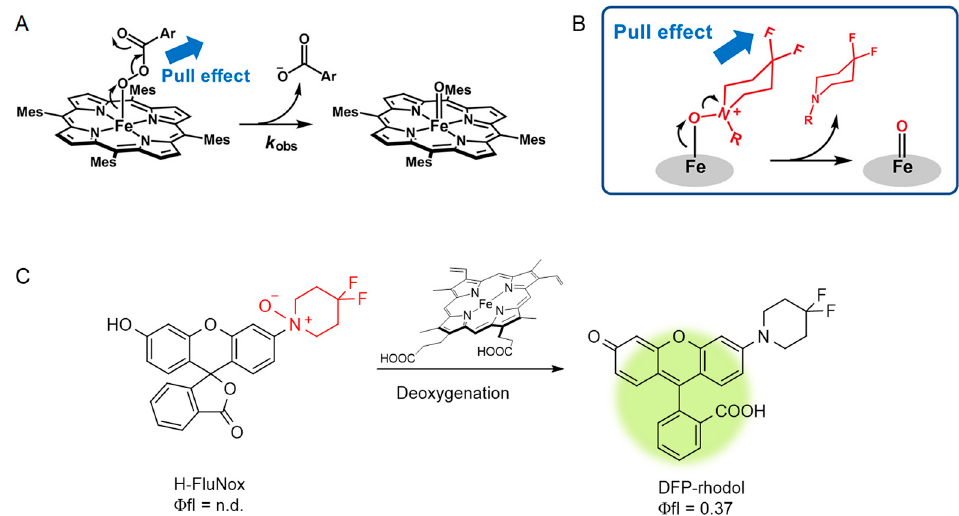
Figure 4. ( A ) Biomimetic reaction of cytochrome P450 with tetramesitylporphyrin iron complex and perbenzoic acid derivatives. ( B ) Design strategy of heme − selective probe. ( C ) Structure of H − FluNox and its fluorescence turn − on response mechanism with Fe 2+ . Reprinted/adapted with permission from Ref. [43]. Copyright 2022, American Chemical Society.